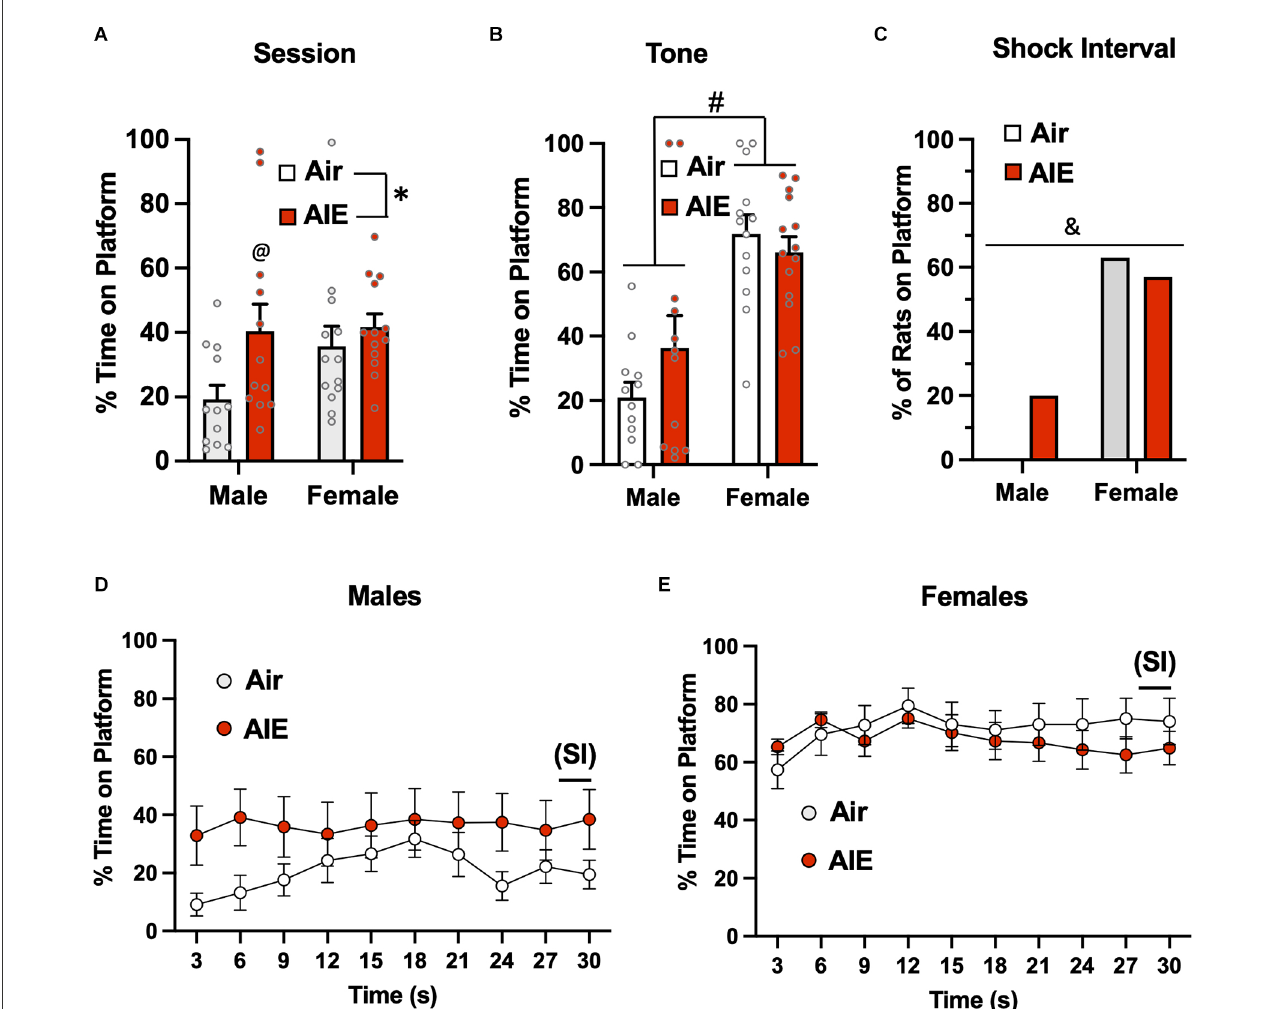
FIGURE6 Active avoidance behavior assessed on the last day of extinction of the platform-mediated avoidance task. (A) When the percentage of time the rats were located on the platform was examined over the entire extinction session, male AIE-exposed rats exhibited significant increases in time on the platform compared to the male Air rats. (B) When analysis of time on the platform was restricted to the period of the tones, the female rats continued to spend significantly more time on the platform. (C) Chi-square analysis also revealed there was a significant difference in the percentage of rats considered to have remained on the platform during the 2-s shock interval (SI). Analysis of the time-course in 3 s bins of when the male (D) and female (E) rats were located on the platform during the tone presentations revealed a significant main effect of time in the female rats. Data represent the means ± sem (except for the contingency date in panel C ; n = 12–13/group). ∗ indicates significant difference between Air and AIE, p = 0.028; @ indicates significant difference between the male Air and male AIE rats, p = 0.018; # indicates significant difference between male and female rats, p = 0.000; & indicates significant group difference, p =